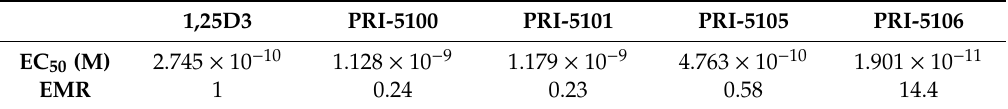
Table 2. Monocytic di ff erentiation induced by 1,25D3 and analogs.